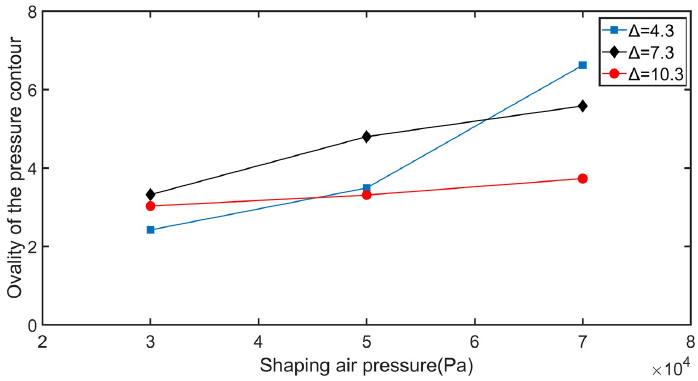
Figure 17. Ovality of the spraying contour on the target surface.